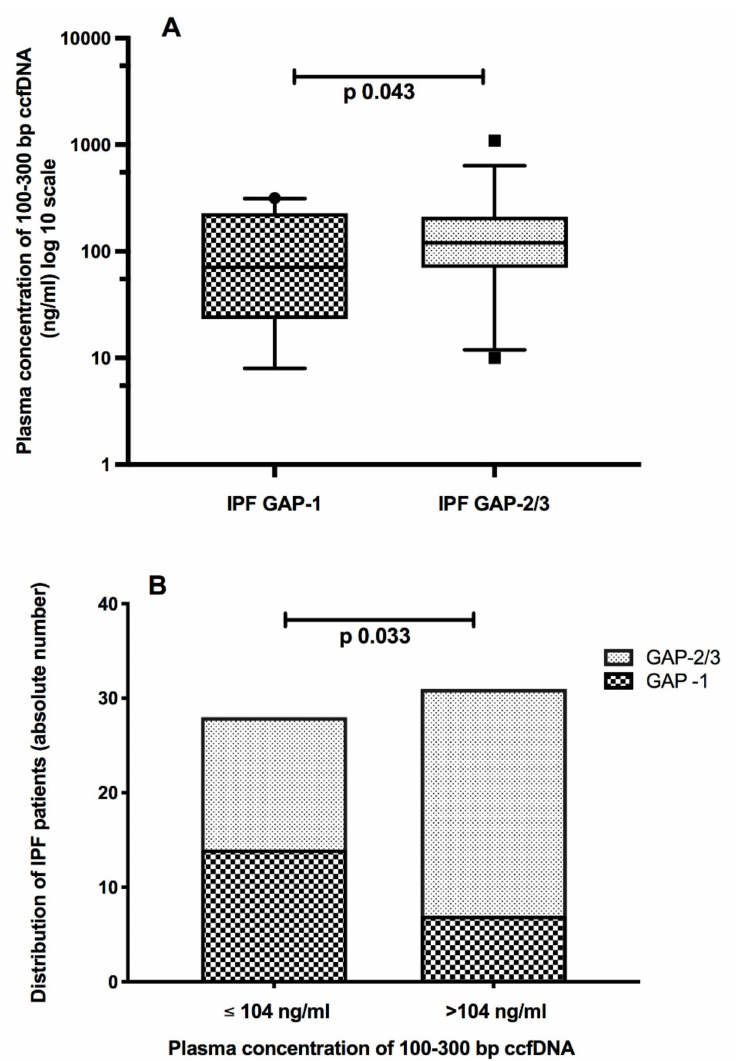
Figure 3. Plasma concentrations of 100–300 bp circulating cell-free DNA (ccfDNA) were significantly higher in idiopathic pulmonary fibrosis (IPF) patients with more advanced disease, according to the GAP (gender-age-physiology) staging score ( A ). The median cut-off of 104 ng/mL helps discriminat- ing patients with advanced vs. milder disease ( B